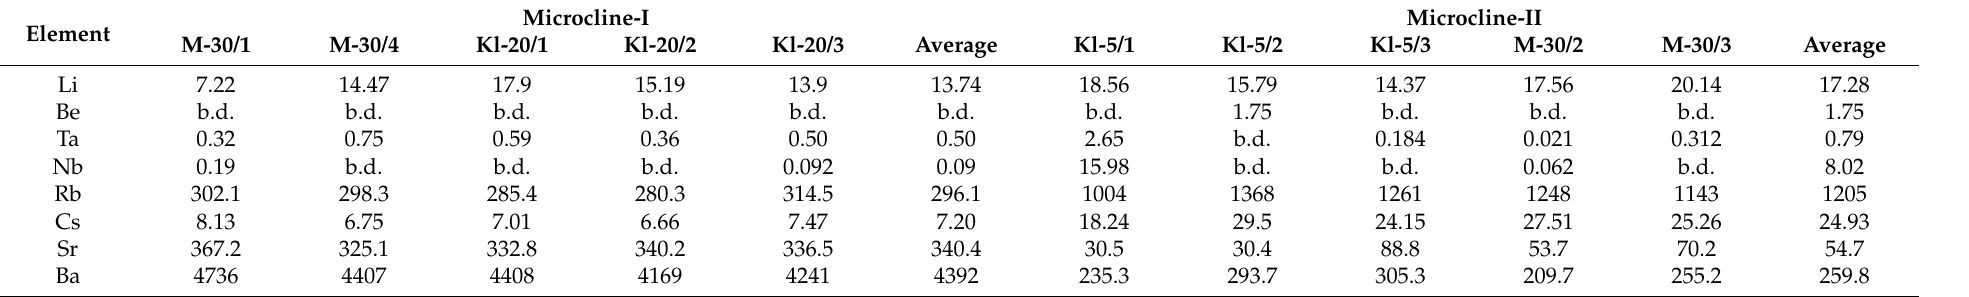
Table 4. Minor and trace elements in the K-feldspar from the feldspar pegmatites (ppm) determined by